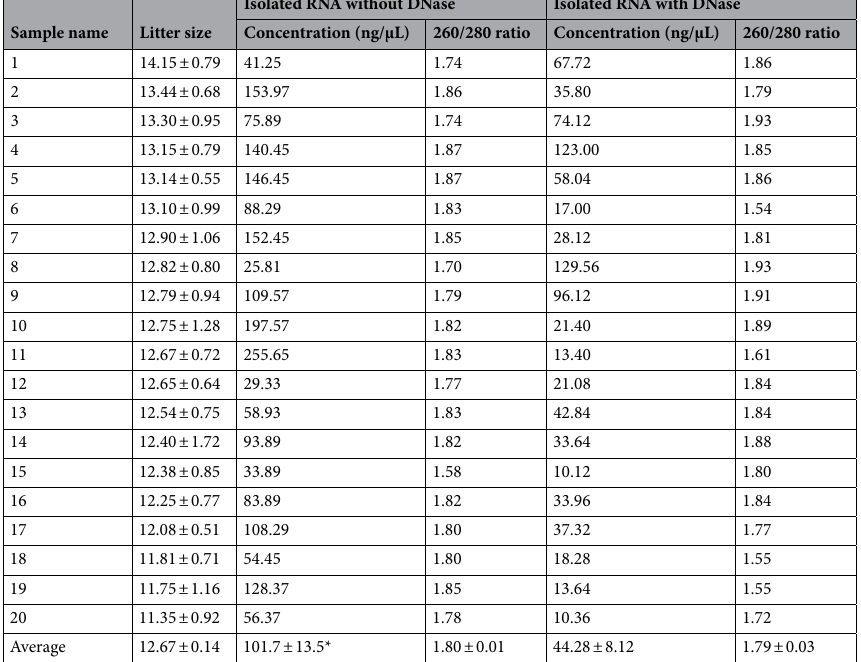
Table 1. Isolated RNA from randomly selected 20 boar spermatozoa. The male fertility data (total litter size) and RNA quantity and quality of isolated RNA with or without DNase in 20 randomly selected